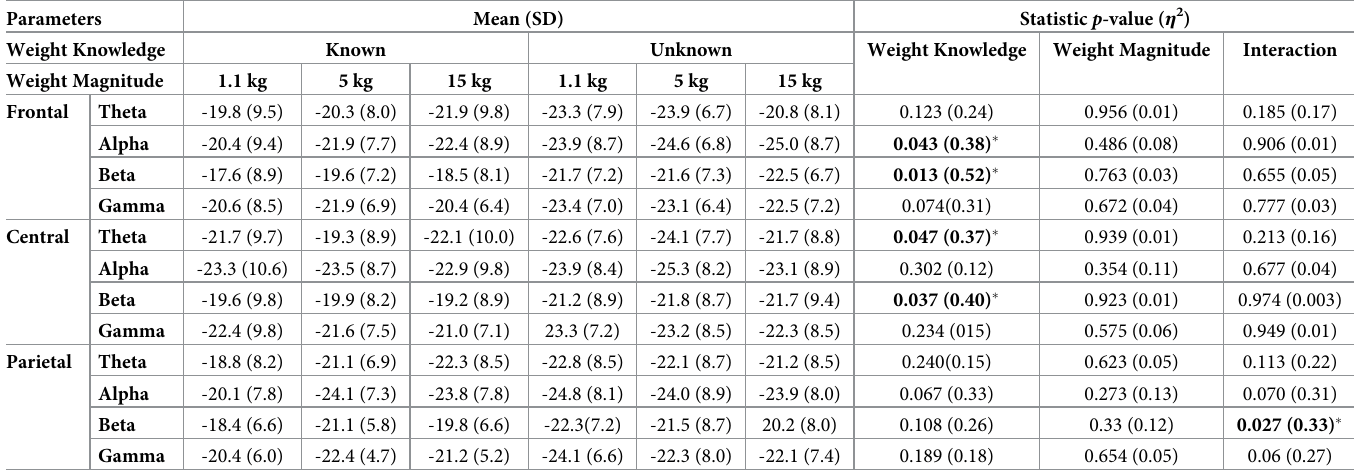
Table 3. Means, Standard Deviations (SD), p -values, and effect sizes ( η 2 ) of the Power Spectrum Density (PSD) of the four EEG bands in the three brain